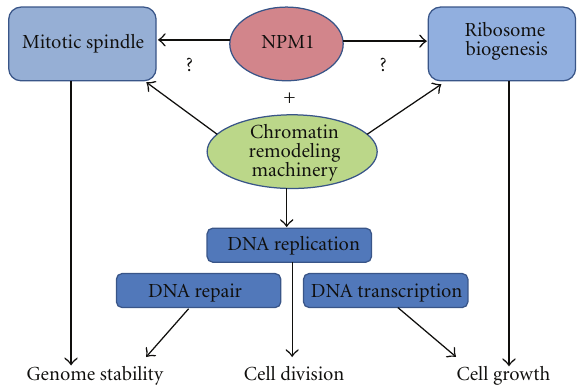
Figure 3: NPM1 is a multifunctional histone binding protein. NPM1 can a ff ect DNA replication, repair and transcription by interacting with the components of chromatin such as histones and chromatin remodeling proteins. NPM1 is also required for a controlled progression through mitosis and NPM1 can promote ribosome biogenesis. These e ff ects may arise through the ability of NPM1 to bind histones at the centromeres or in the nucleolus,